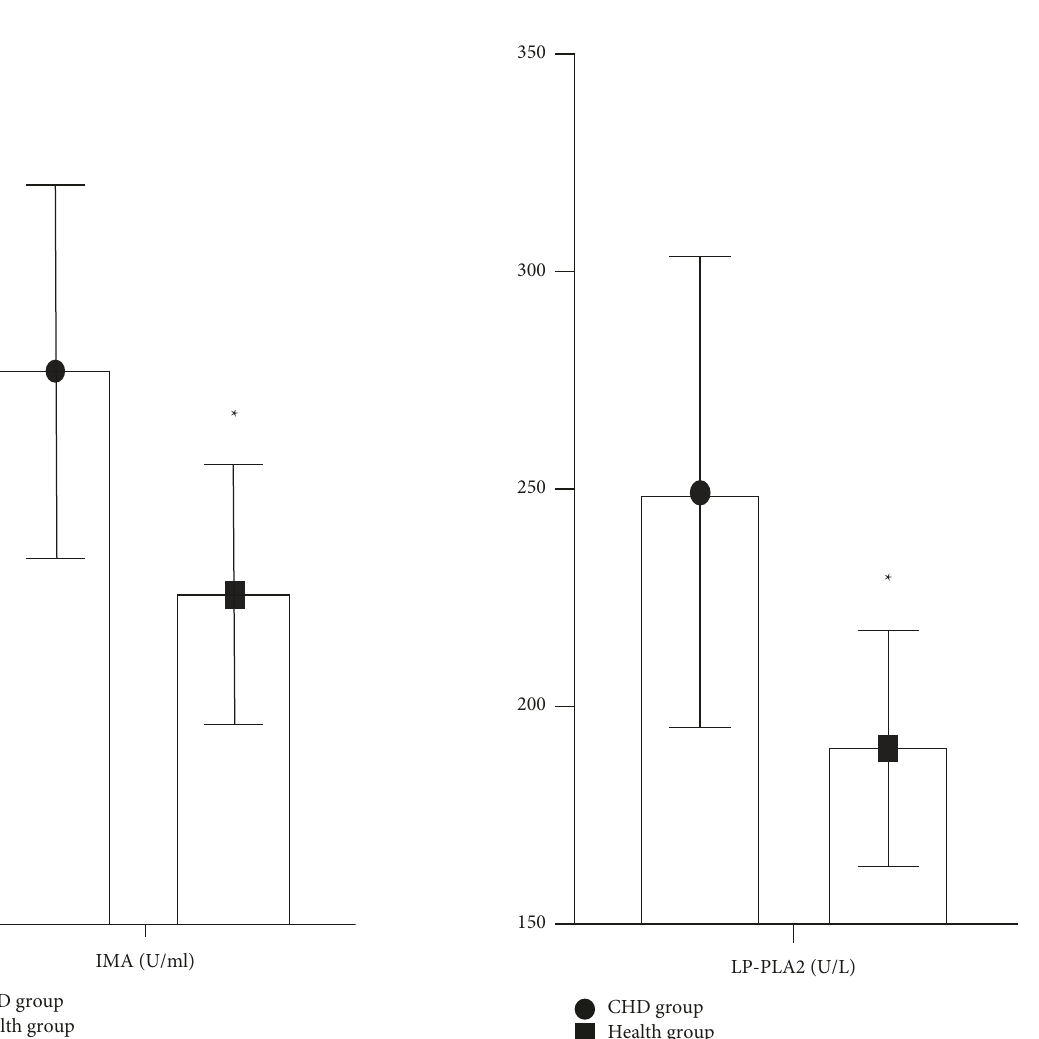
Figure 4: Serum LP-PLA2 level (U/L). Note: ∗ is P < 0 . 05 compared with the CHD